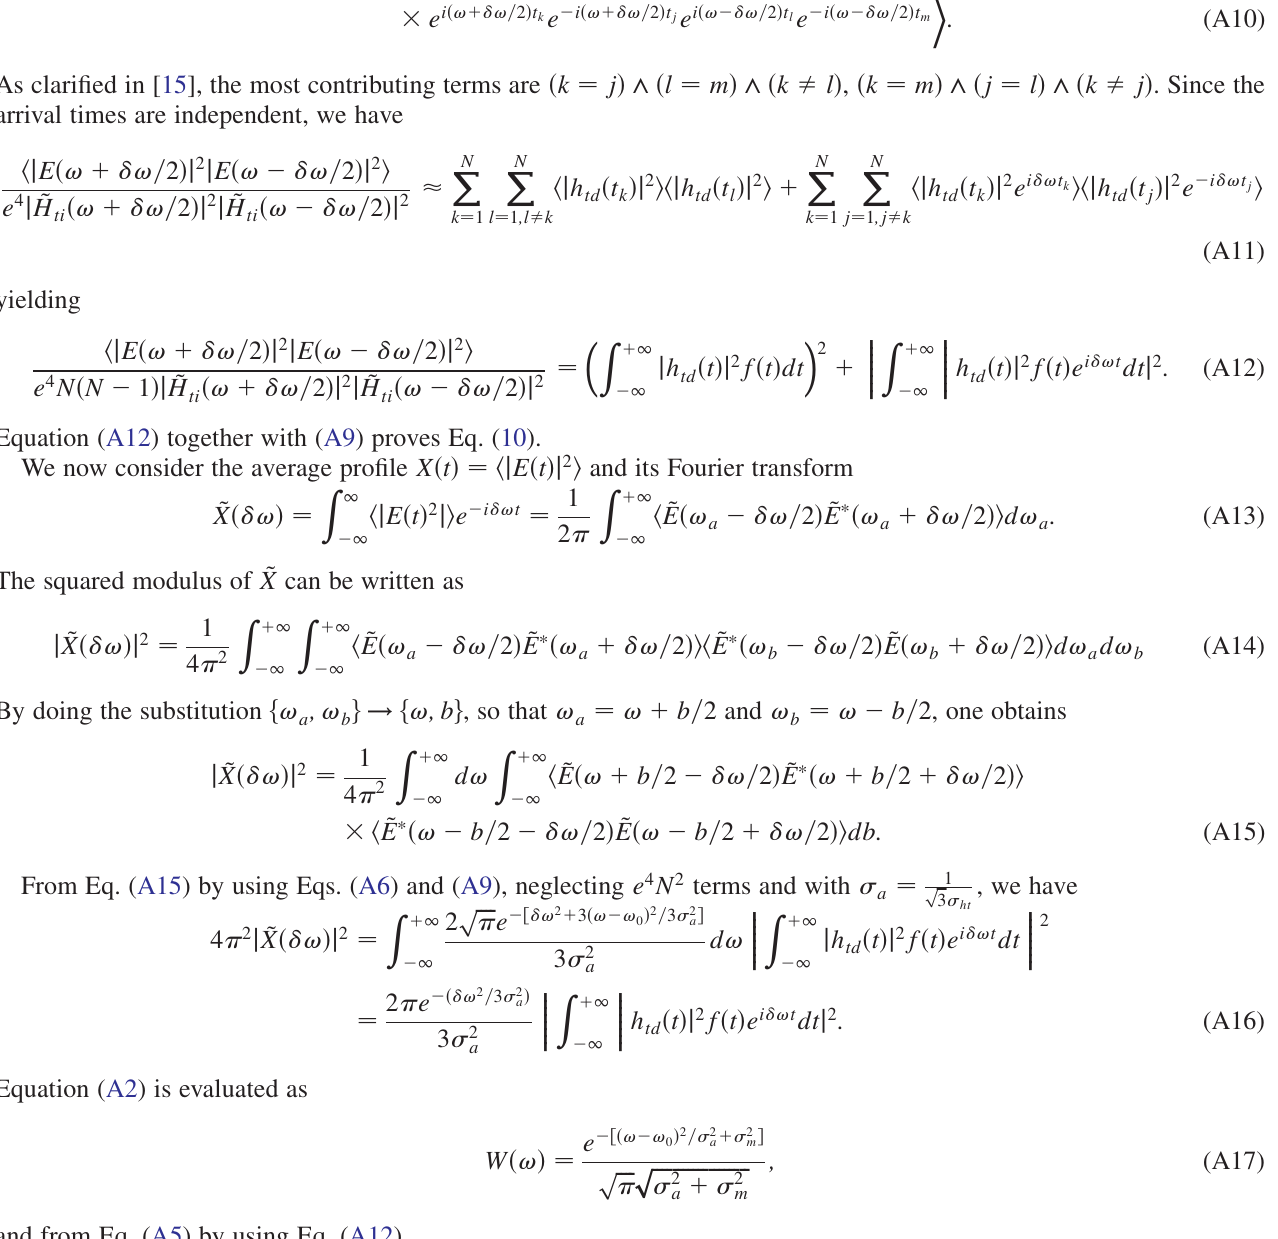
ffiffiffiffiffiffiffiffiffiffiffiffiffiffiffiffiffiffiffi